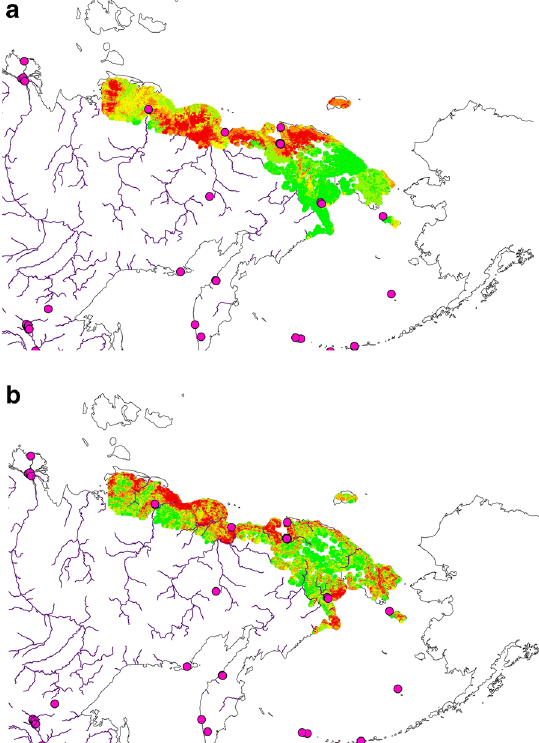
Figure 5. Predictions of Tundra Bean Goose ( Anser fabalis) ( a ) brood-rearing parents with broods, and ( b ) post-breeding nonbreeders for the study area). The map predictions are presented as a ‘heatmap’ of the relative index of occurrence (RIO): red is a high RIO and green is a low RIO. Best-available GBIF presence location for this species are superimposed for assessment; they are shown as pink points. Map created by FH with OpenSource QGIS and ArcGIS Desktop 10.6 academic